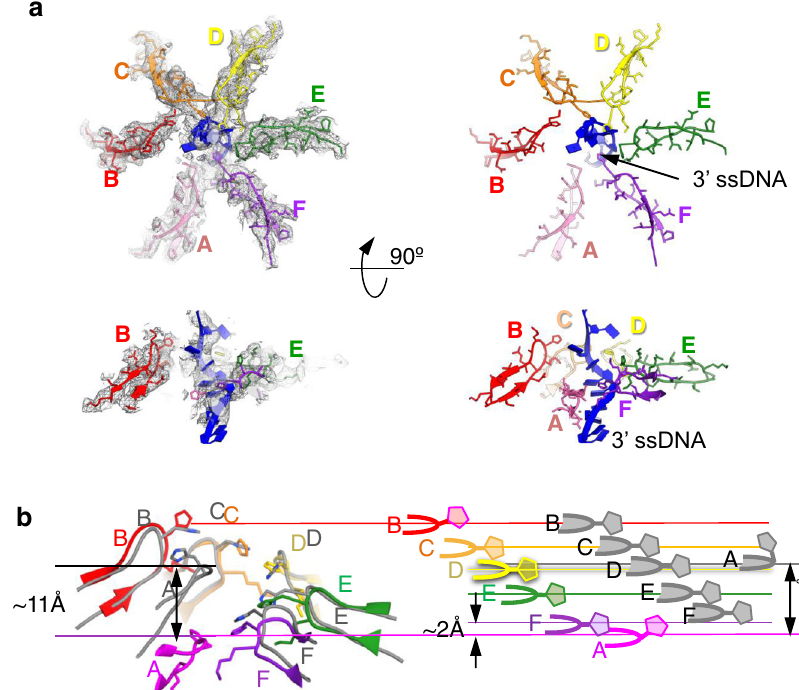
Fig. 6 Interactions of the DNA-binding β -hairpins with the 3 ′ -ssDNA. a Top left, a cross-section of E1RF viewed from the top showing the fi tted atomic model of the six DNA-binding β -hairpins in the EM map (grey mesh). The bottom left panel displays a side view of the same area revealing the staircase organisation of the β -hairpins. The right panels show the same slices of the atomic models with amino acid side chains to show interactions with the 3 ′ ssDNA. b Overlay of the DNA-binding β -hairpins from the fi tted atomic model of the E1RF cryo-EM map (in colours corresponding to the E1 subunits) and the X-ray structure of E1HD/ssDNA/ADP 14 (in grey, PDB 2GXA). On the right, a cartoon illustrates the step-wise organisation of the individual DNA- binding β -hairpins in each structure. His507s are shown and their relative heights within the central channel of the AAA +